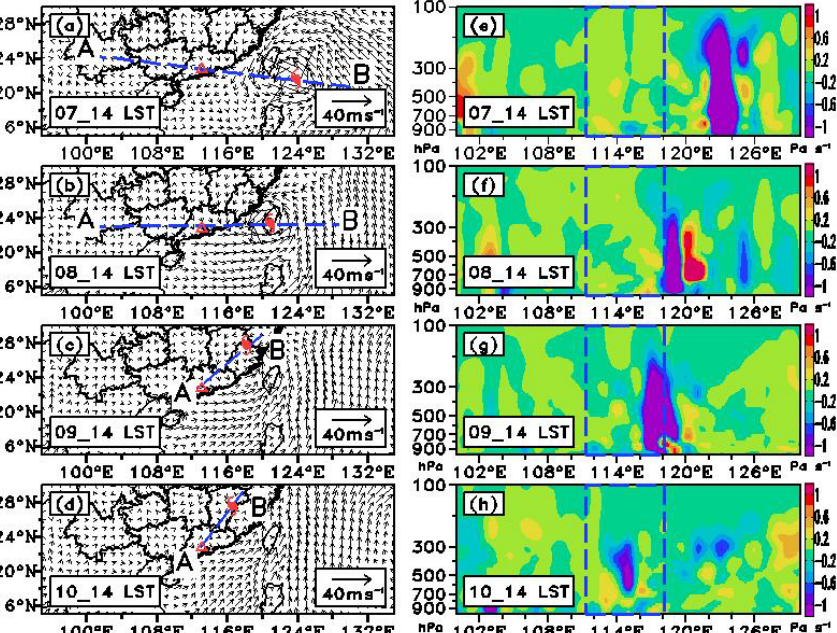
Figure 2. (a–d) The 1000hPa wind vectors of NCEP-FNL data from 14:00 (7 July) to 14:00 (10 July) with red triangle and typhoon symbols representing the locations of the PRD centre and Nepartak, respectively. (e–h) Vertical cross sections of vertical velocity along the four straight lines linking PRD and the centres of Typhoon Nepartak in (a–d) from 14:00 on 7 July to 14:00 on 10 July 2016. The four dashed blue boxes denote the longitude range of PRD in (e–h)